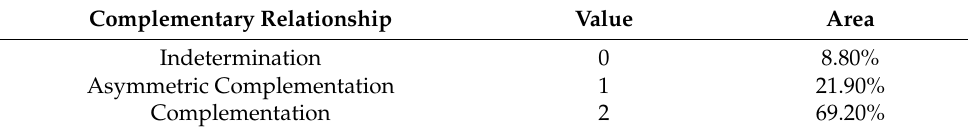
Table 7. Types of complementary relationship between AET and PET in Ningxia.